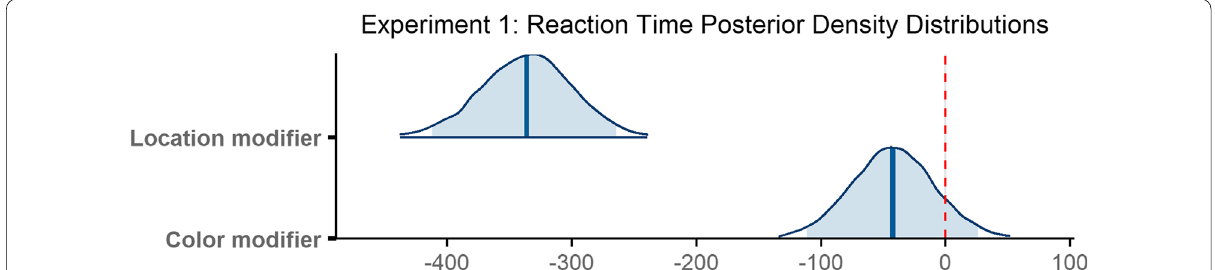
Fig. 7 Posterior density distributions for reaction time β parameter estimates for each level of the fixed effect relative to the reference level. Light blue shaded regions indicate the 95% credible interval, and blue vertical lines indicate the mean of the distribution. The red vertical dashed line highlights 0 on the x axis. If the red line falls within the light blue shaded region, the estimate is not reliably different from zero and interpreted as a null